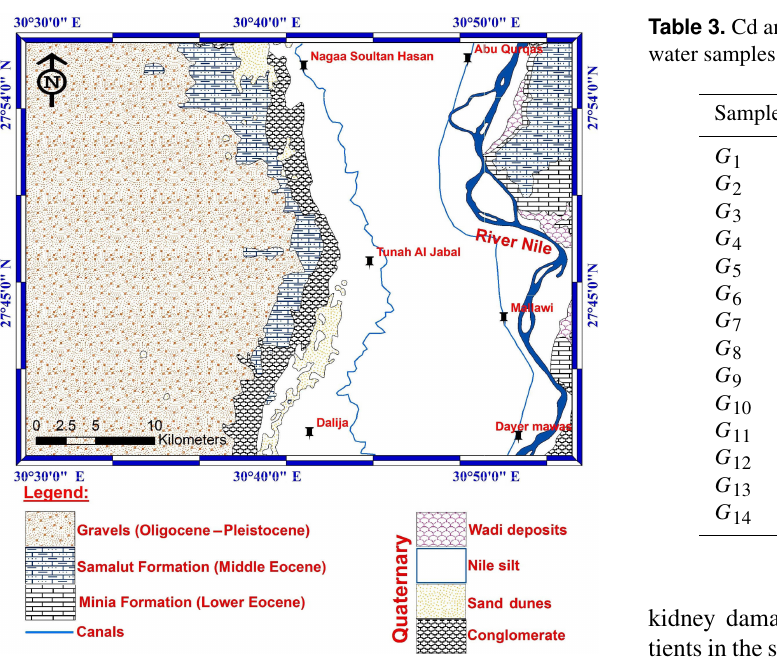
Figure 2. Geologic map of the study area.